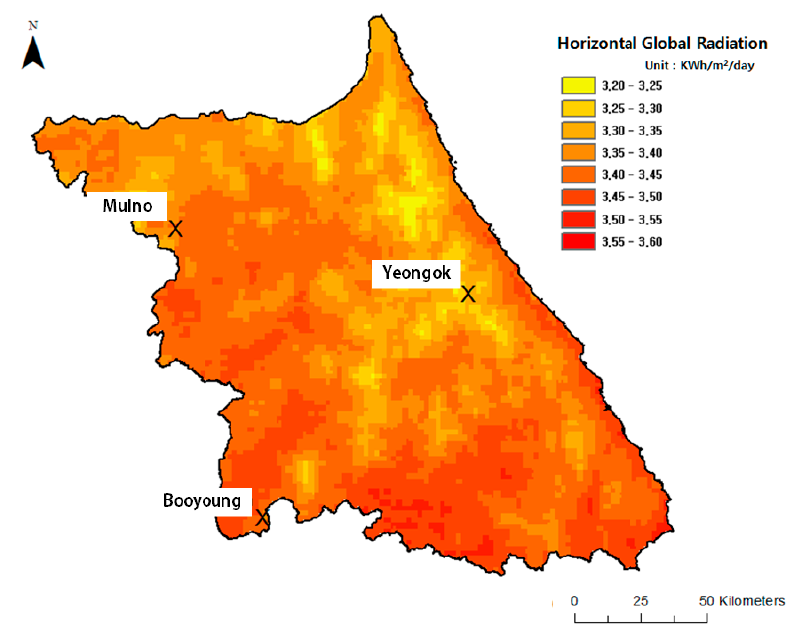
Figure 7. GIS DB map showing annual mean daily global horizontal radiation (kWh / m 2 / day) at the surface (Song et al. [58]).